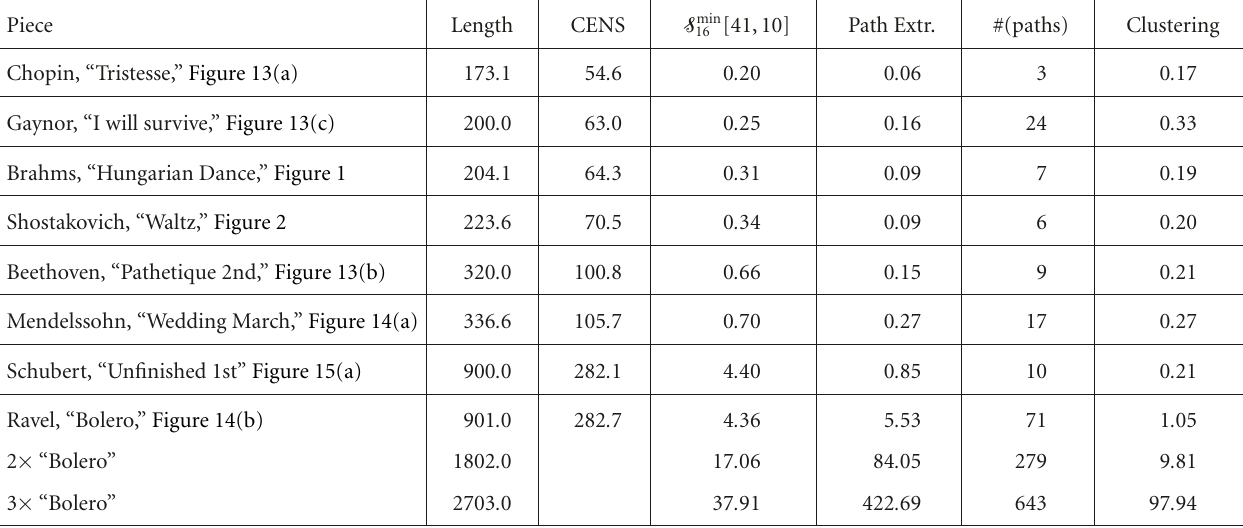
Table 2: Running time behavior of the overall structure analysis algorithm. All time durations are measured in seconds. The columns indicate the respective piece of music, the duration of the piece, the running time to compute the CENS features (Section 2), the running time to compute the self-similarity matrix (Section 3), the running time for the path extraction (Section 4), the number of extracted paths, and the running time for the clustering algorithm (Section